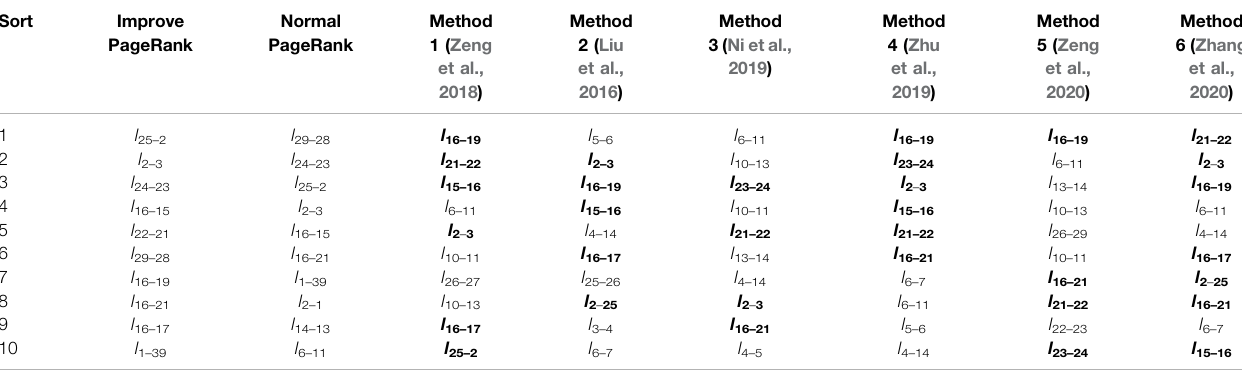
TABLE 2 | Comparison between the method of this paper and the others.